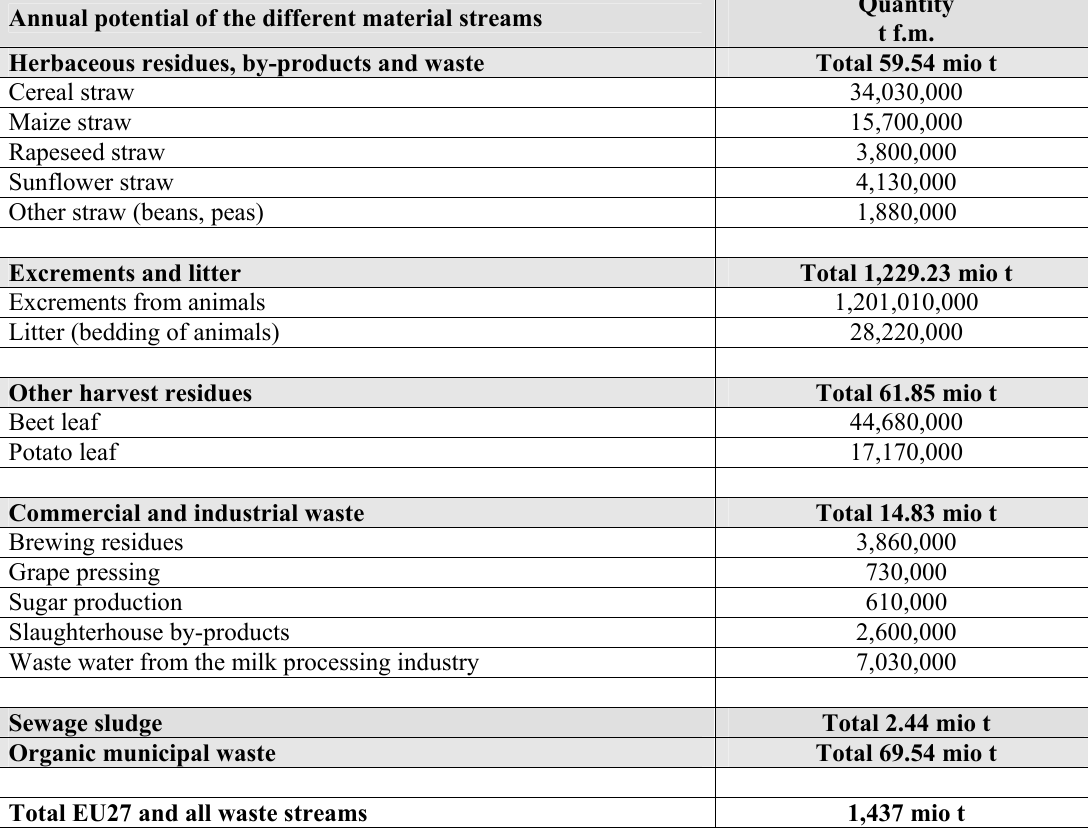
Table 42: Potential of different organic residues and waste streams in EU27 for 2020 (Thrän,